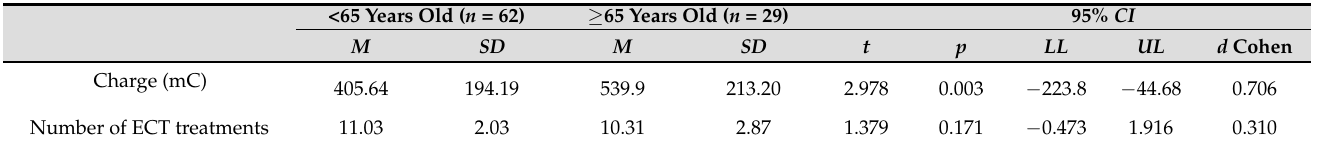
Table 2. Mean energy charge and number of ECT treatments by